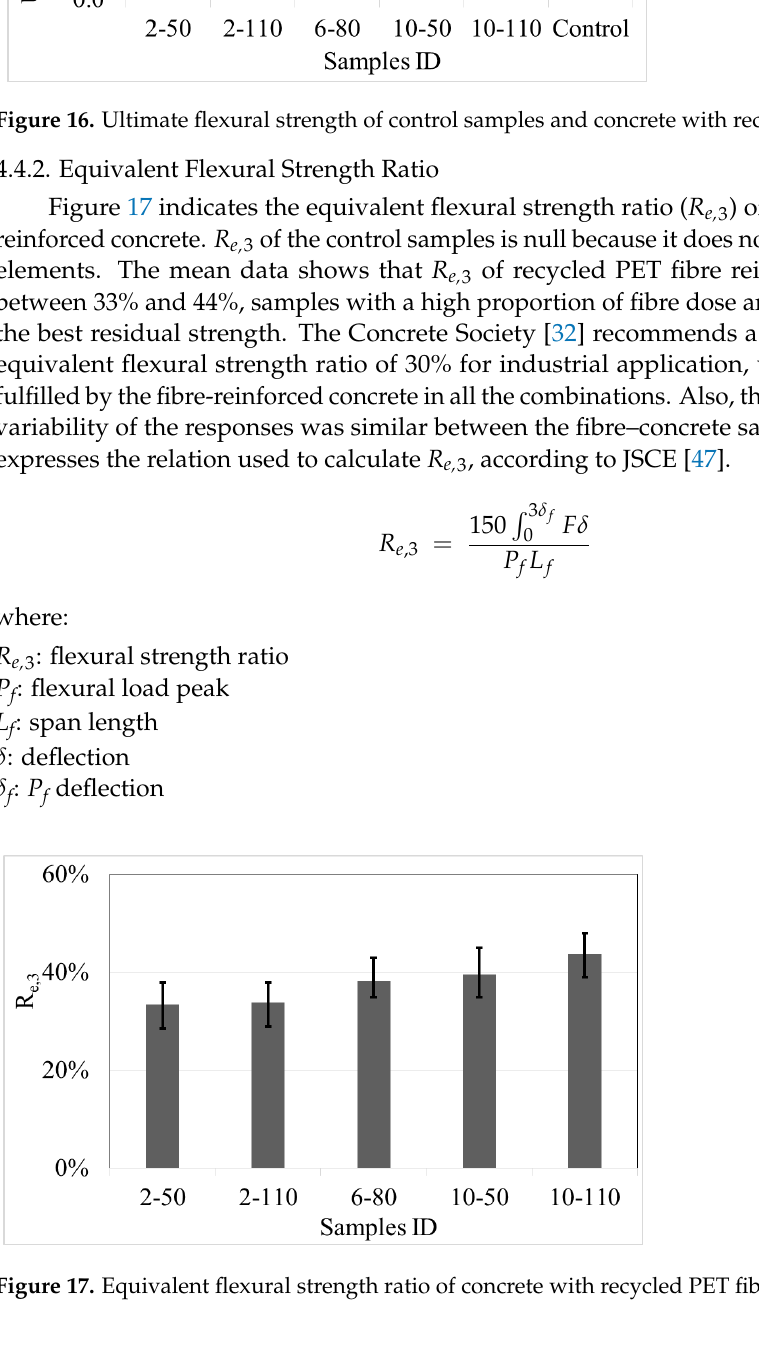
Figure 16. Ultimate flexural strength of control samples and concrete with recycled PET fibres.